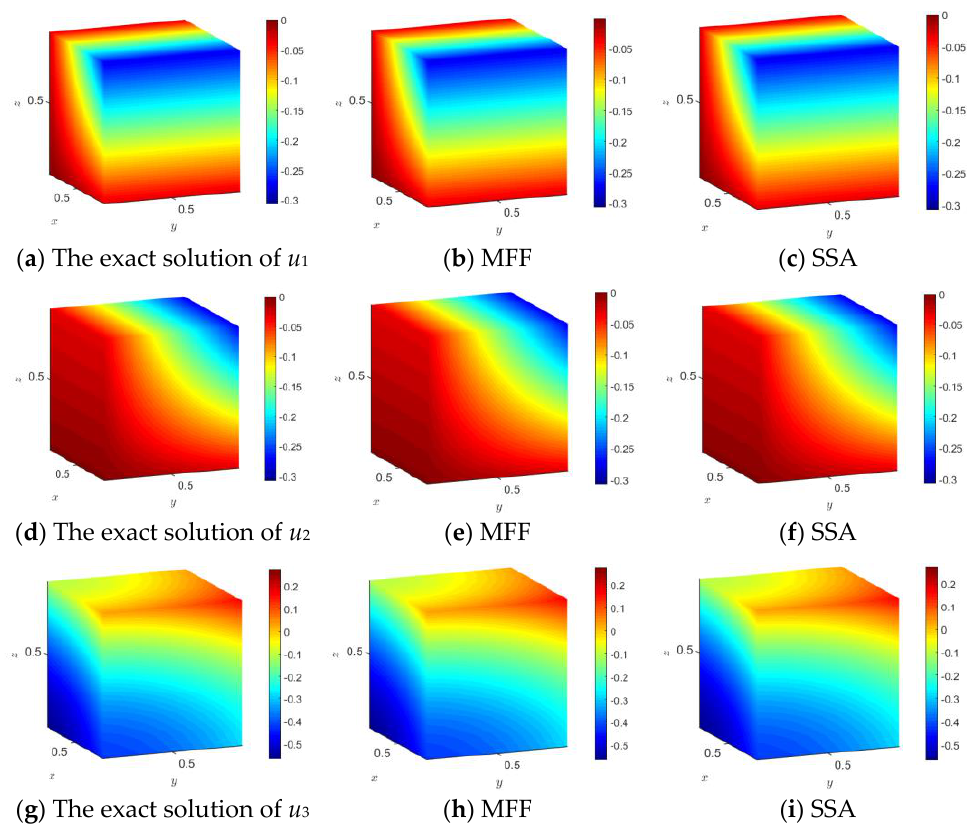
Figure 16. Displacements of u 1 , u 2 , and u 3 calculated by the improved RBFCM with R = 5.